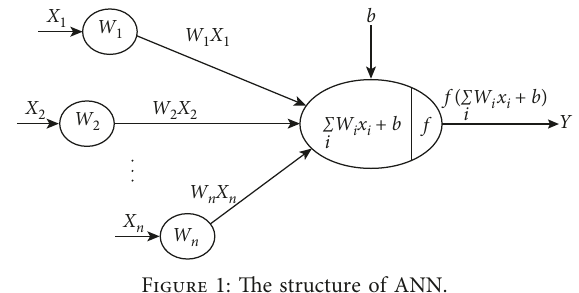
Figure 1: The structure of